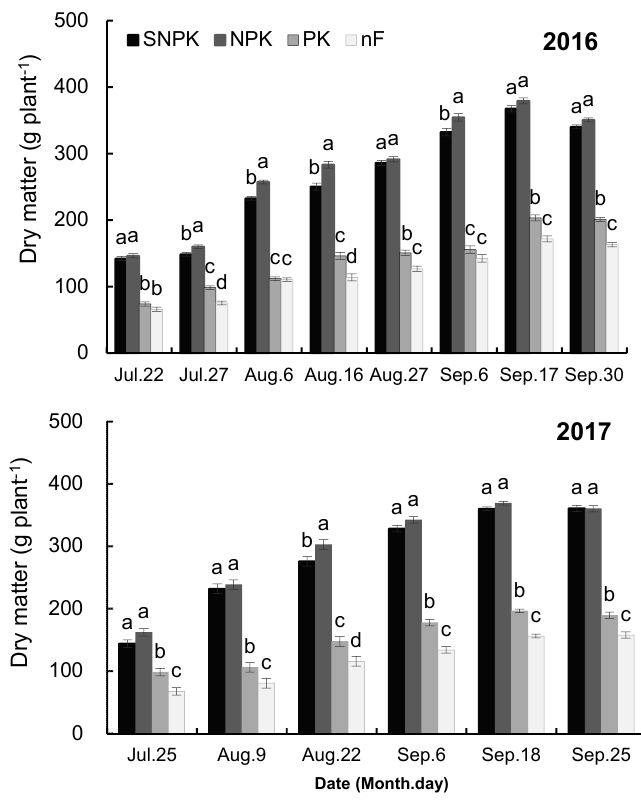
Figure 2. Dry matter dynamics post-flowering of single maize plant as effect of long-term fertilizer treatment SNPK, NPK, PK, and nF. SNPK represents combination of maize straw, chemical nitrogen, phosphorus, and potassium, NPK represents treatment of chemical nitrogen, phosphorus, and potassium, PK represents chemical phosphorus and potassium, and nF represents no fertilizer. Values with the same letter are not significantly different at p < 0.05, comparison within the same sampling date. Bars: Standard error of the mean.